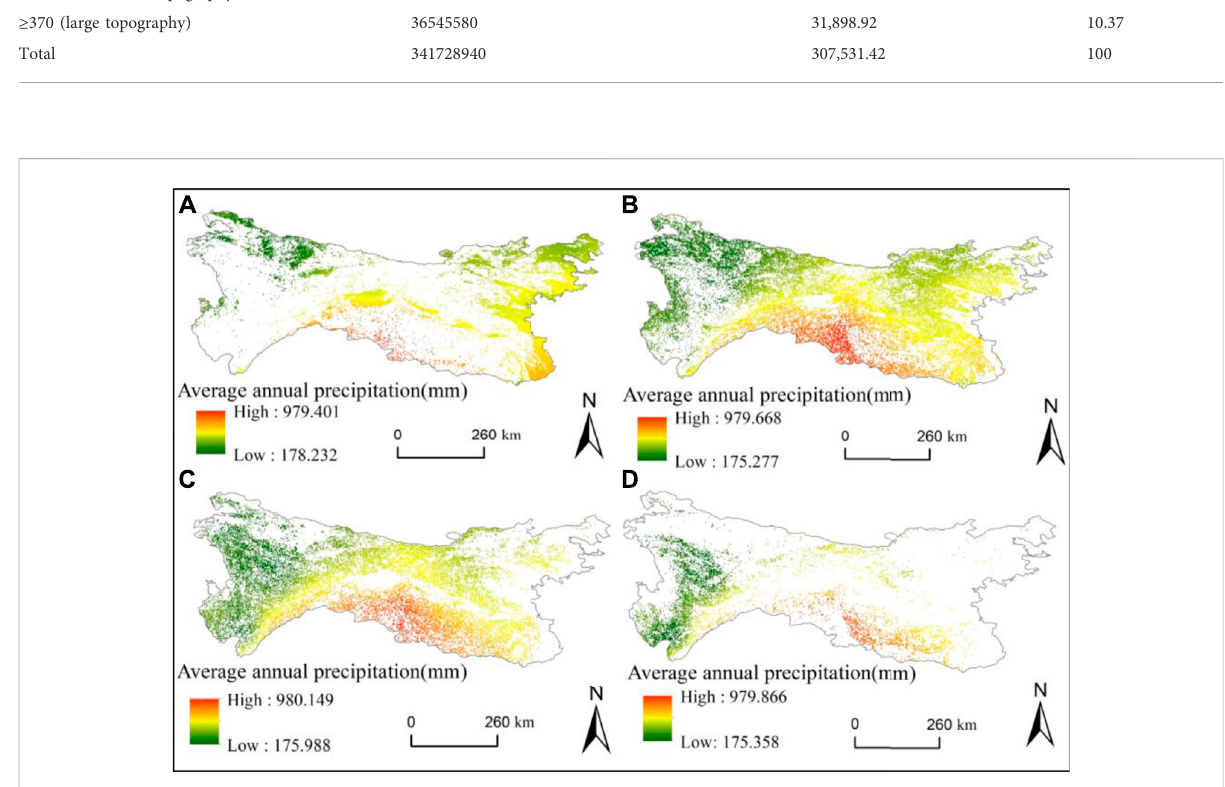
FIGURE 10 Spatial distribution of average annual precipitation over micro-topography (A) , small topography (B) , medium topography (C) , and large topography (D)